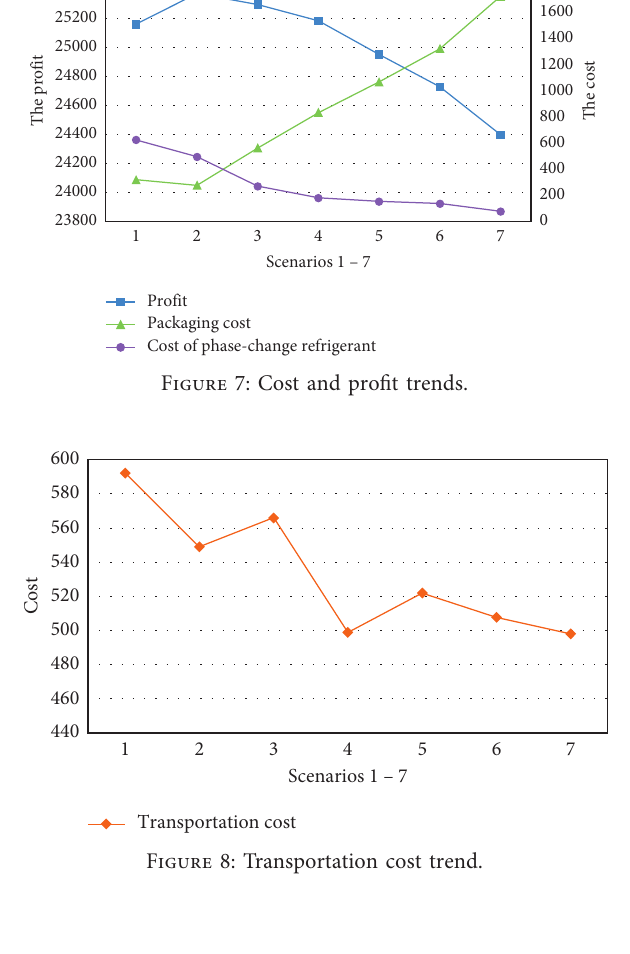
Table 8: Results of the calculation for each scenario. Profit